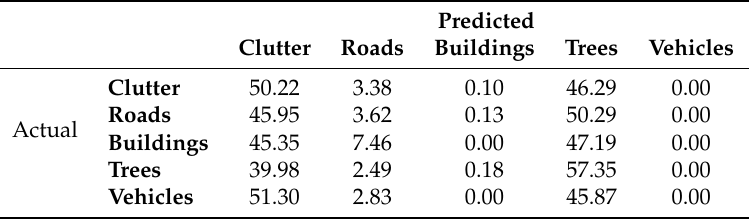
Table A7. Normalized confusion matrix for the GSCNN model that is trained on coordinates and colors, and uses class weights, after 50 epochs.